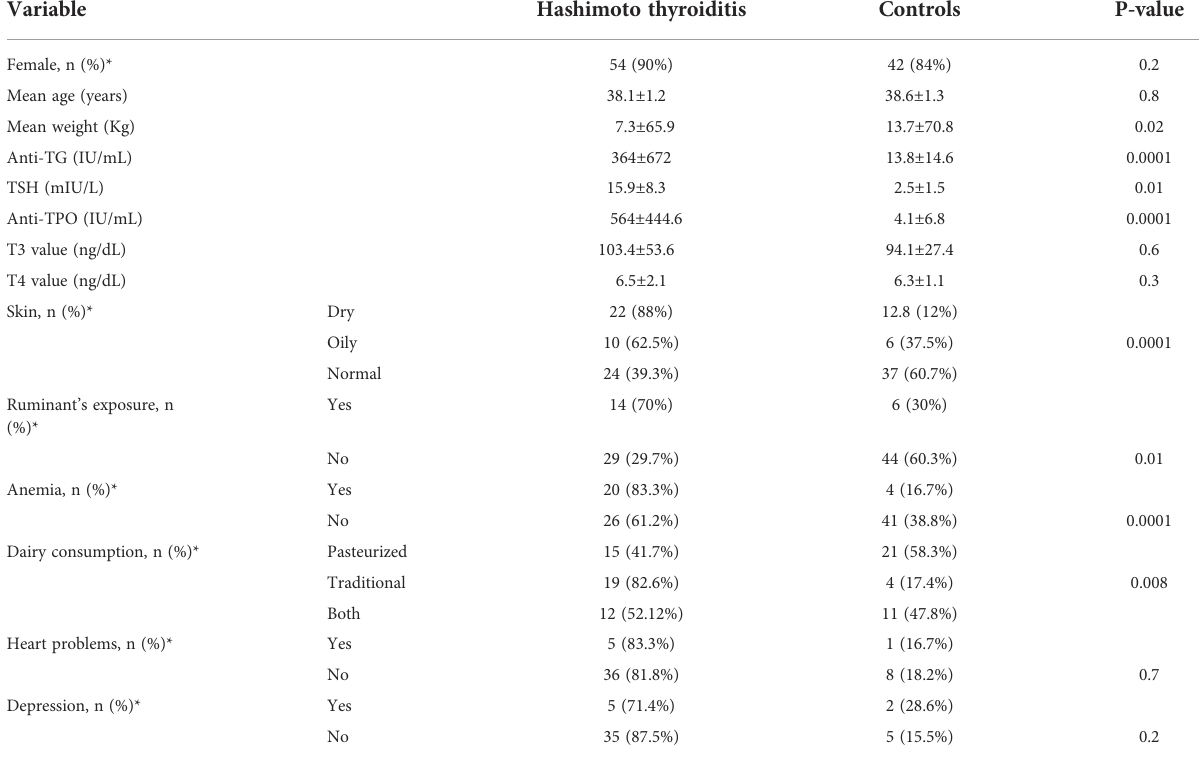
TABLE 2 Demographic, clinical manifestation and laboratory parameters of the participants.